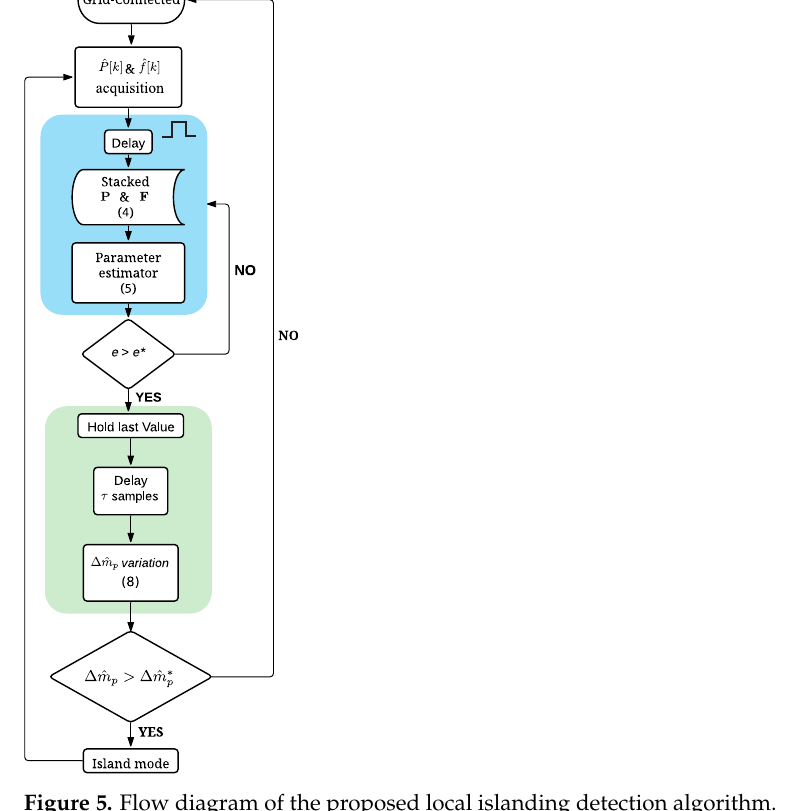
Figure 5. Flow diagram of the proposed local islanding detection